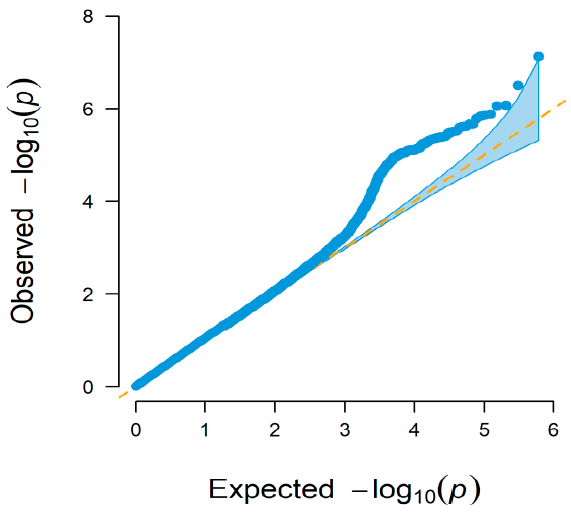
Figure 2. Quantile-quantile (Q-Q) plot of GWAS based on the random regression model. The x-axis and y-axis represent − log 10 transformed expected p -values and observed p -values, respectively. The dots indicate − log 10 ( p ) of the SNPs and the diagonal line represents the expected values under the null hypothesis for no association.